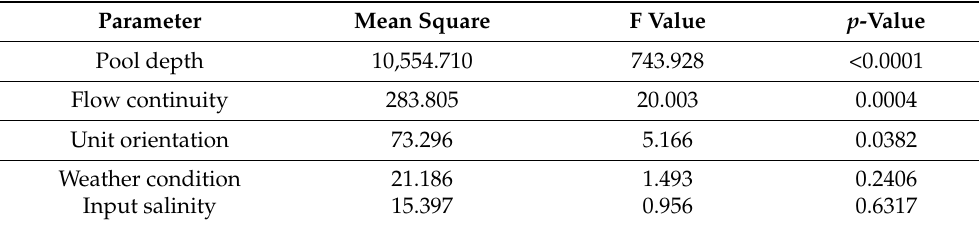
Table 2. ANOVA of the parameters influencing the water production efficiency.